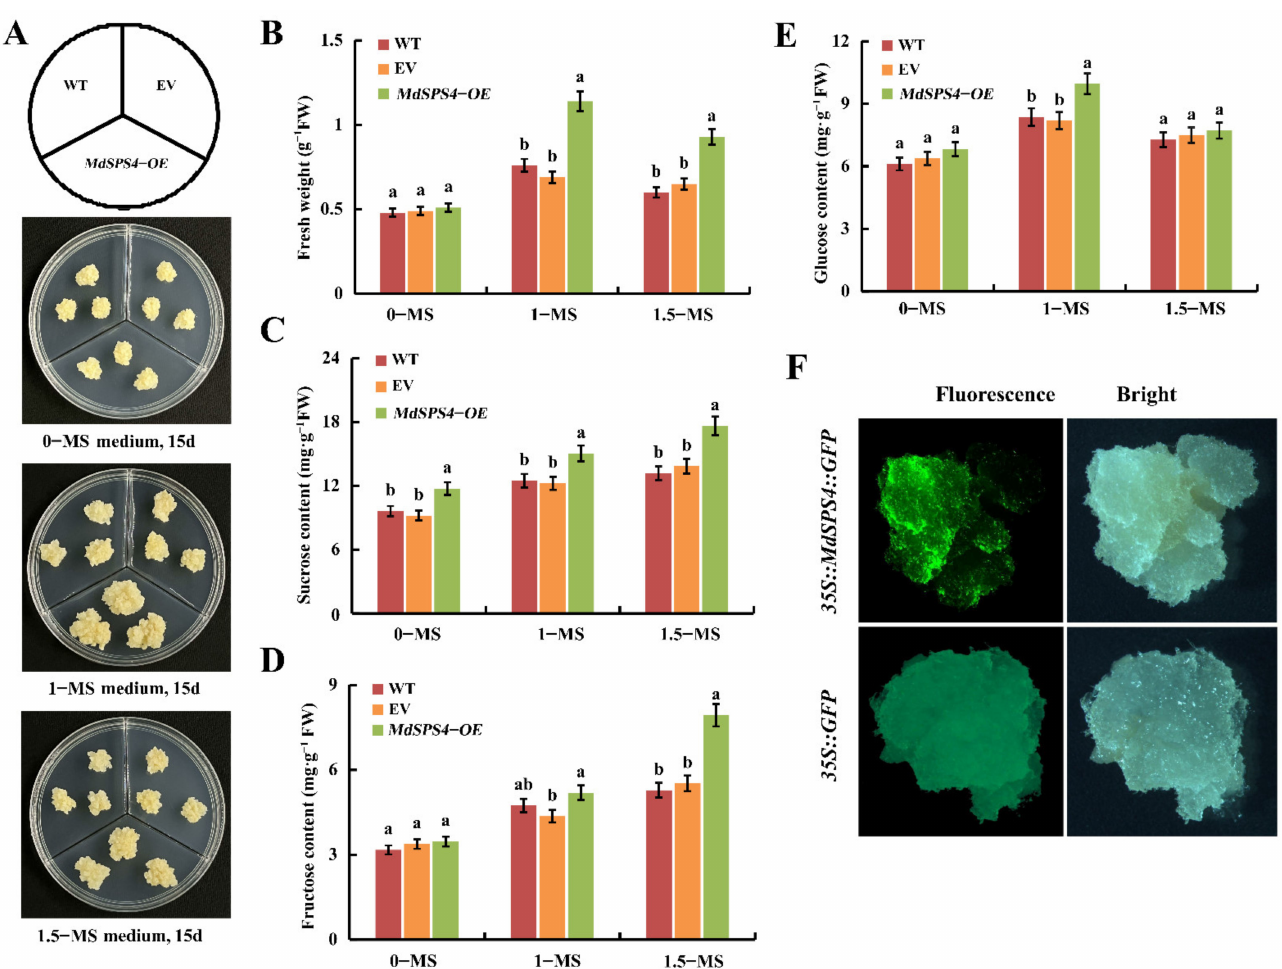
Figure 10. Effect of MdSPS4 on different nitrogen levels in transgenic apple calli. ( A ) The phenotypes of WT, EV, and transgenic apple calli were cultured on 0–MS, 1–MS, and 1.5–MS medium for 15 days. ( B ) Fresh weight. ( C ) Sucrose content. ( D ) Fructose content. ( E ) Glucose content. ( F ) Fluorescent photo of transgenic MdSPS4 apple calli. Error bars represent the means ± SD ( n = 3) taken from three independent biological replicates. Different letters represent significant differences (LSD test, p <